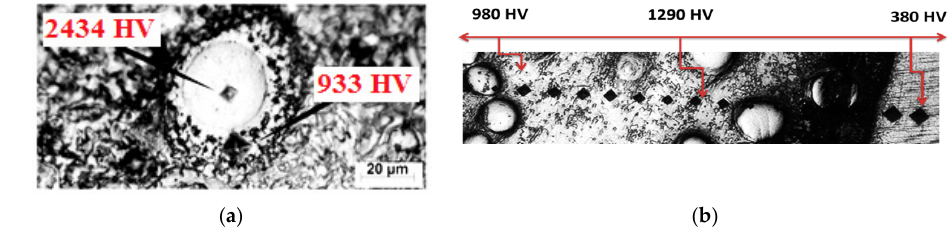
Figure 16. ( a ) High hardness value inside the WC particle; and ( b ) microhardness variations along the clad layer toward the substrate.